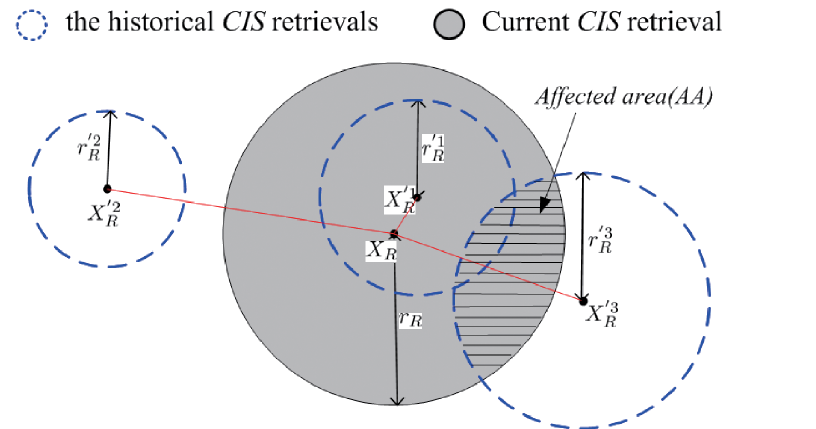
Fig 6. An example of the edge buffering scheme.